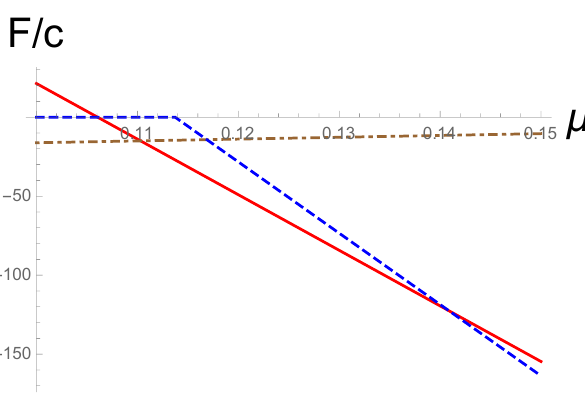
Figure 3 . Free energy of the one-cut, \smallest" BTZ, and thermal AdS con(cid:12)gurations as a function of (cid:22) 5 for k = 1 ; s 1 = 38 ; q = 0 : 6. The solid red, dashed blue and dotted brown lines represent F 1-cut =c , min F BTZ =c , and F AdS =c respectively. There is a region of (cid:22) 5 where free energy F 1-cut (solid red line) is smaller than the two